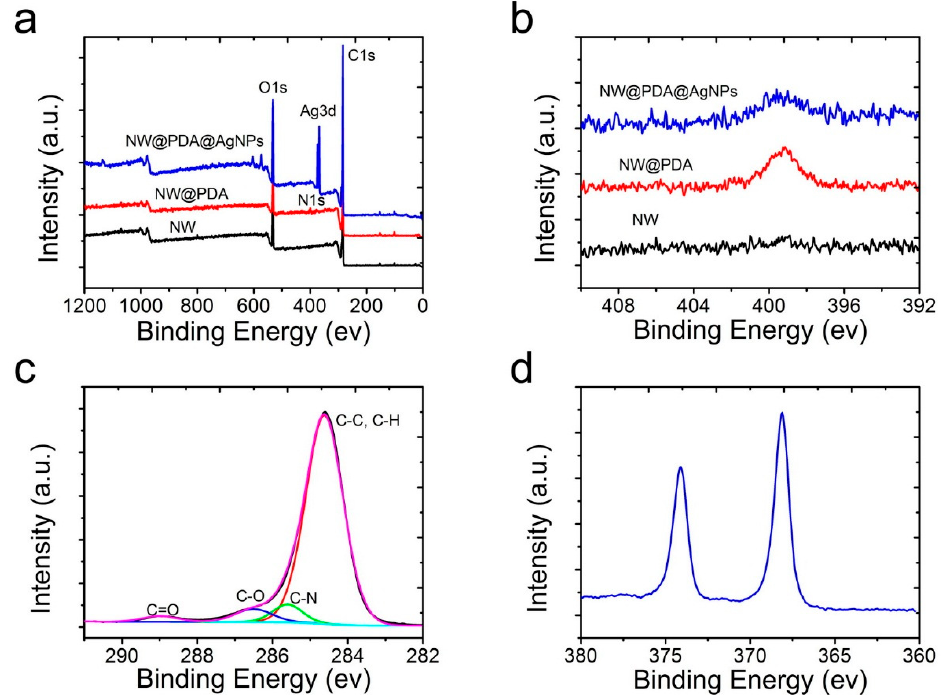
Figure 3. ( a ) X-ray photoelectron spectroscopy (XPS) survey of the pristine NW, NW@PDA, and